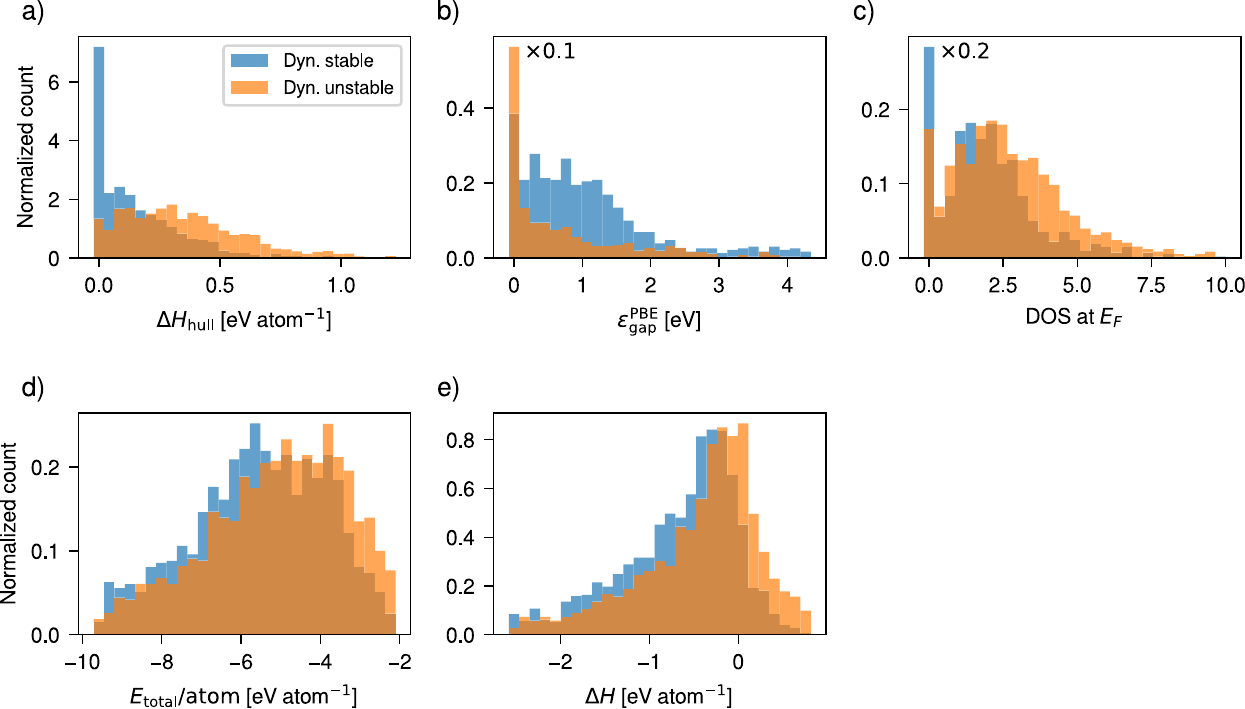
Fig. 8 Histograms of electronic features for stable and unstable materials. a Shows the distribution of the energy above the convex hull for high and low stability predicted materials. The stable materials tend to be closer to the convex hull. b Shows that materials predicted to be stable more frequently have a PBE band gap larger than zero. c Shows the DOS at the Fermi level distributions, which supports that stable materials have lower DOS at E F . d is for total energy per atom, which shows a slightly better separation between stable and unstable materials as stable materials tend to have a slightly lower total energy per atom. e The unstable materials tend to have a slightly larger heat of formation. Note that for b and c the peaks at x = 0 for both stable and unstable materials have been scaled down by a factor of 10 and 5, Fig. 9c. Here feature importance refers to how many times a feature is used to perform a split in the decision trees, and the model with a model trained on the low-dimensional fi ngerprint. feature importance has been summed for the six different components of the RAD-PDOS fi ngerprints, i.e., summing the radial distance and energy axes of the fi ngerprint. The vertical 0.82 ± 0.01 to 0.90 ± 0.01. The relative impact of the RAD-PDOS fi ngerprints is shown in the feature importance evaluation in dashed black line shows the feature importance of random noise